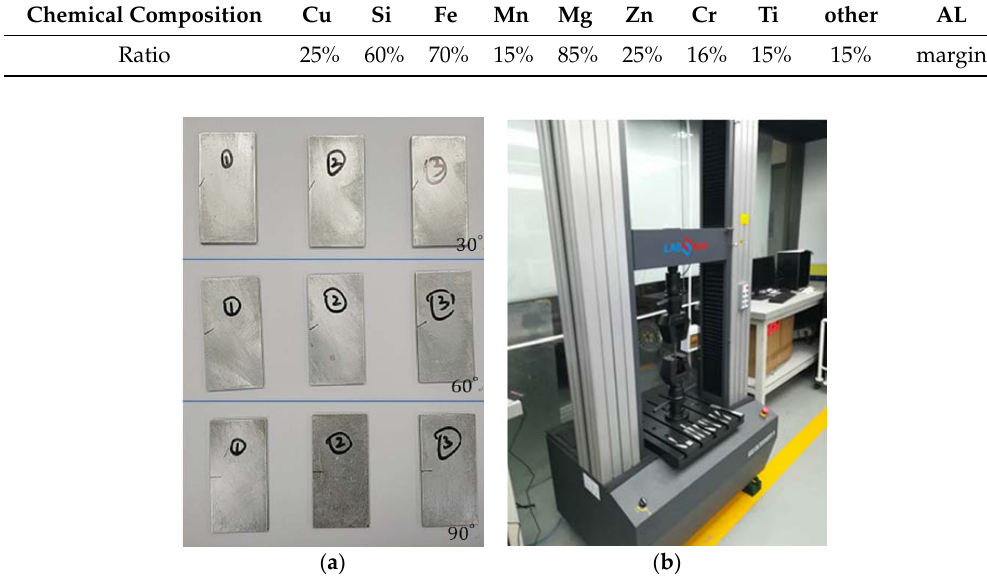
Table 2. Composition of 6061-T6 aluminum alloy.